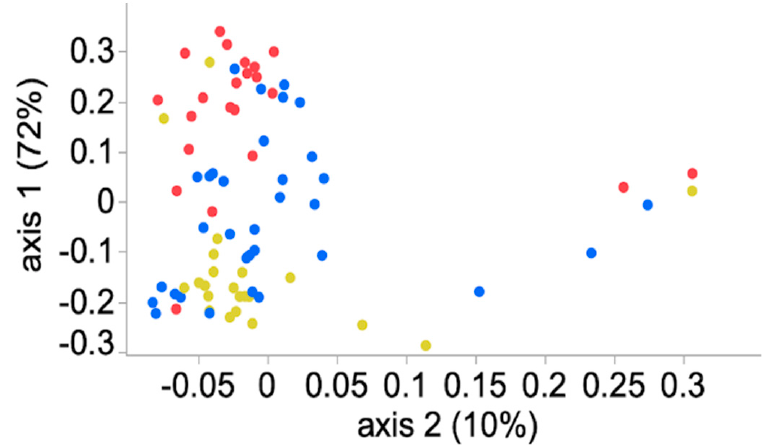
Figure 4. Scatter plot of the community structure (Yue and Clayton index) of the equine fecal microbiota stored at ambient temperature for 0 h to 6 h (yellow), 12 h to 48 h (blue) and 72 h to 96 h (red) before freezing and sample processing.